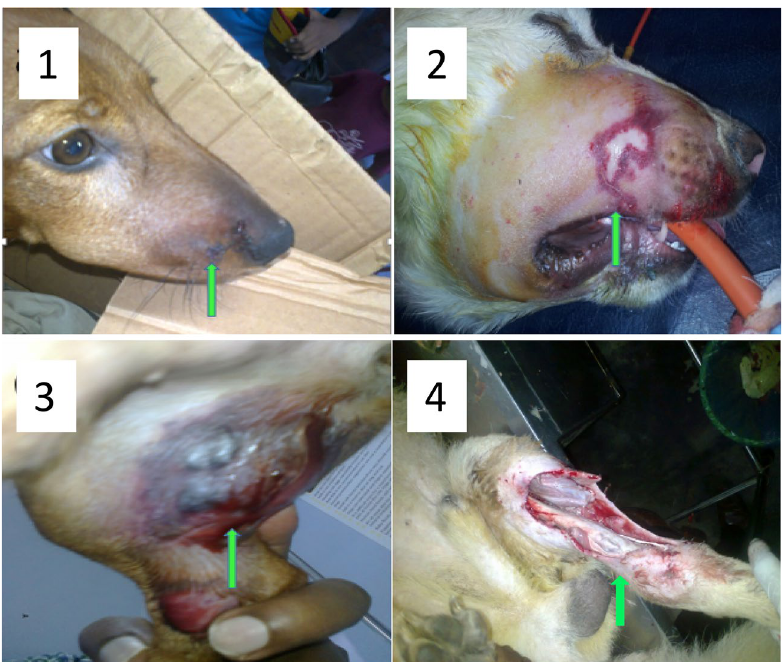
Figure 1. Local tissue reactions observed due to hump-nosed pit viper bite (arrows indicate the site of fang marks/lesions). ( 1 ) Mild swelling, ( 2 ) Extensive swelling, ( 3 ) Hemorrhagic blistering, ( 4 ) Ruptured hemorrhagic